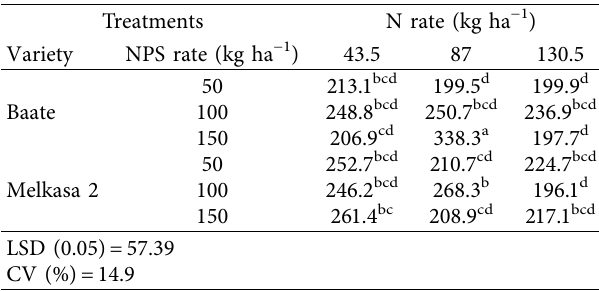
Table 8: Mean values of thousand kernel weight as influenced by the interaction of variety by NPS and N in the 2018 cropping season.